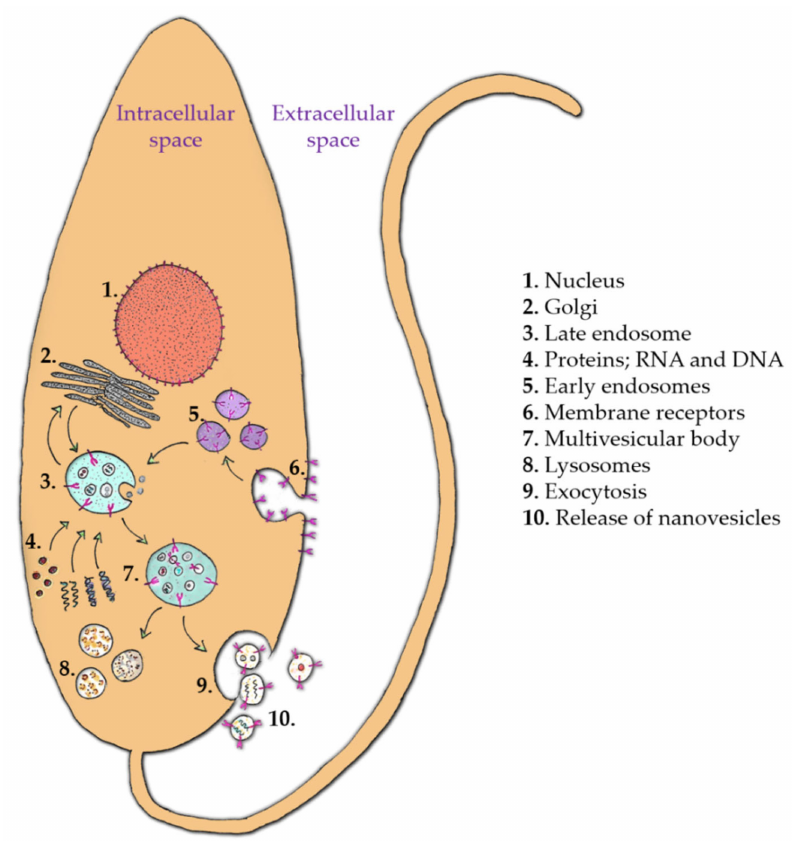
Figure 2. Biogenesis and release of the Leishmania exosomes and vesicle cargo. Diagram showing the development of the nanovesicle, which begins with endocytosis, forming the early endosomes, which develop into late endosomes by inward budding, and finally multivesicular bodies that may either undergo degradation (generating lysosomes) or merge with the cell membrane and, by exocytosis, release intraluminal endosomal vesicles that become exosomes in the extracellular environment